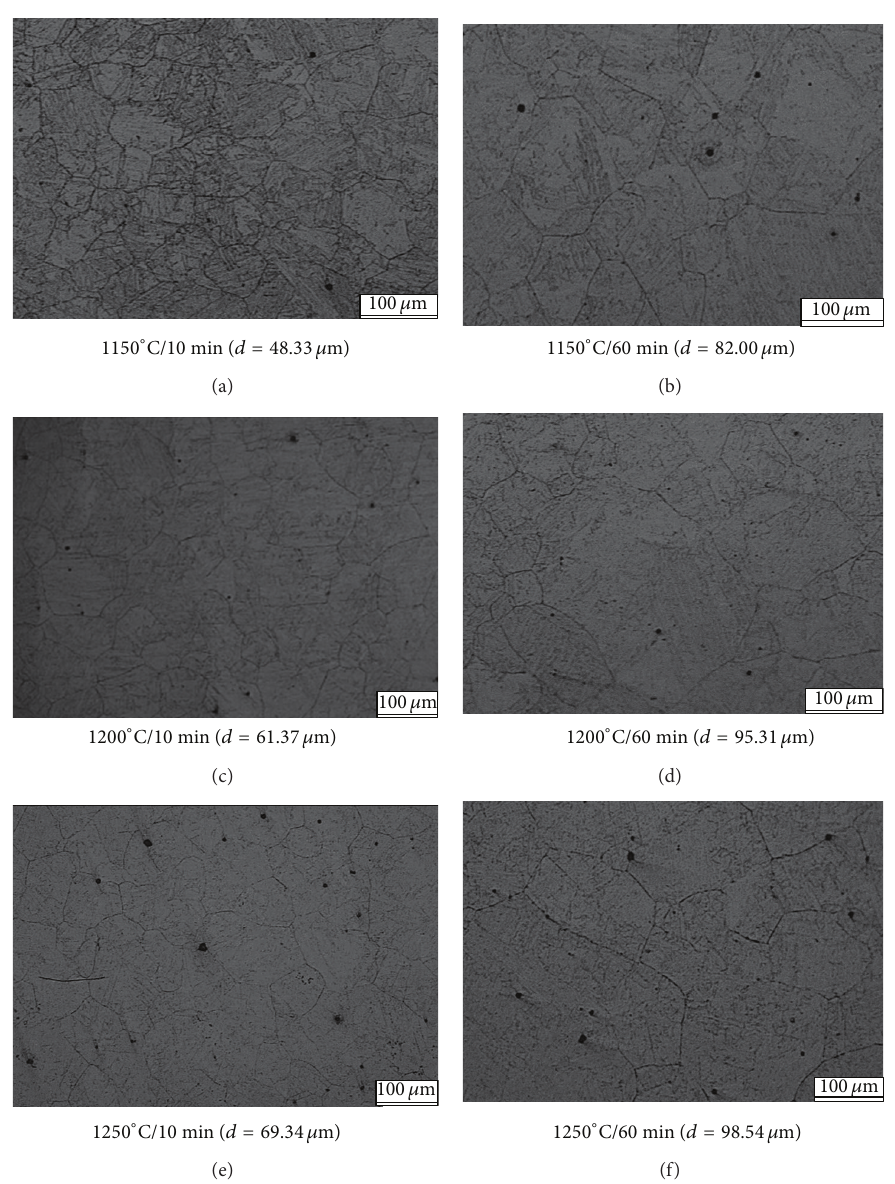
Figure 1: Microstructure micrographs of X65 grade after being heat treated at three temperatures (1150 ∘ C, 1200 ∘ C, and 1250 ∘ C) and holding times (10min. and